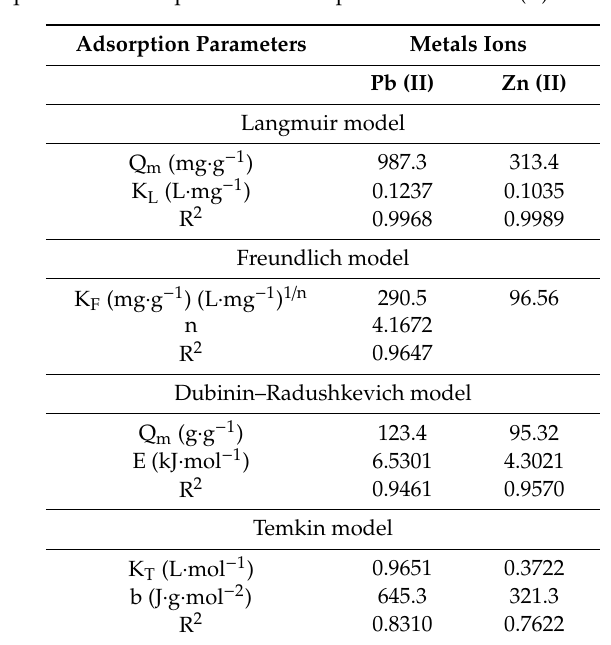
Table 3. Equilibrium adsorption isotherms parameters for Pb (II) and Zn (II) on